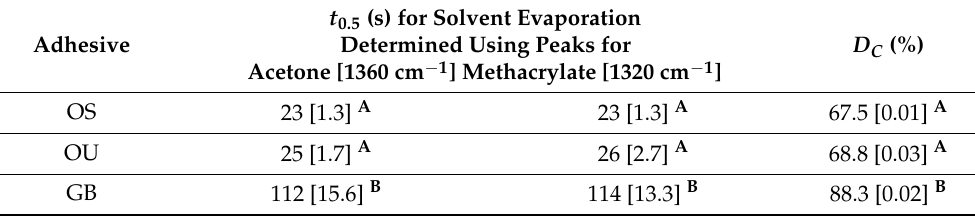
Table 4. Times of half maximum solvent evaporation/methacrylate concentration change and final degrees of monomer conversion [standard errors] ( n = 3) . Different capital letters in the same column indicate statistically significant differences (Games–Howell, p < 0.05). D C and t 0.5 values were both significantly higher for GB than for the other two adhesives. (N.B. t 0.5 for polymerization are not provided, as all were below 10 s and rates too fast to determine with high accuracy with the method